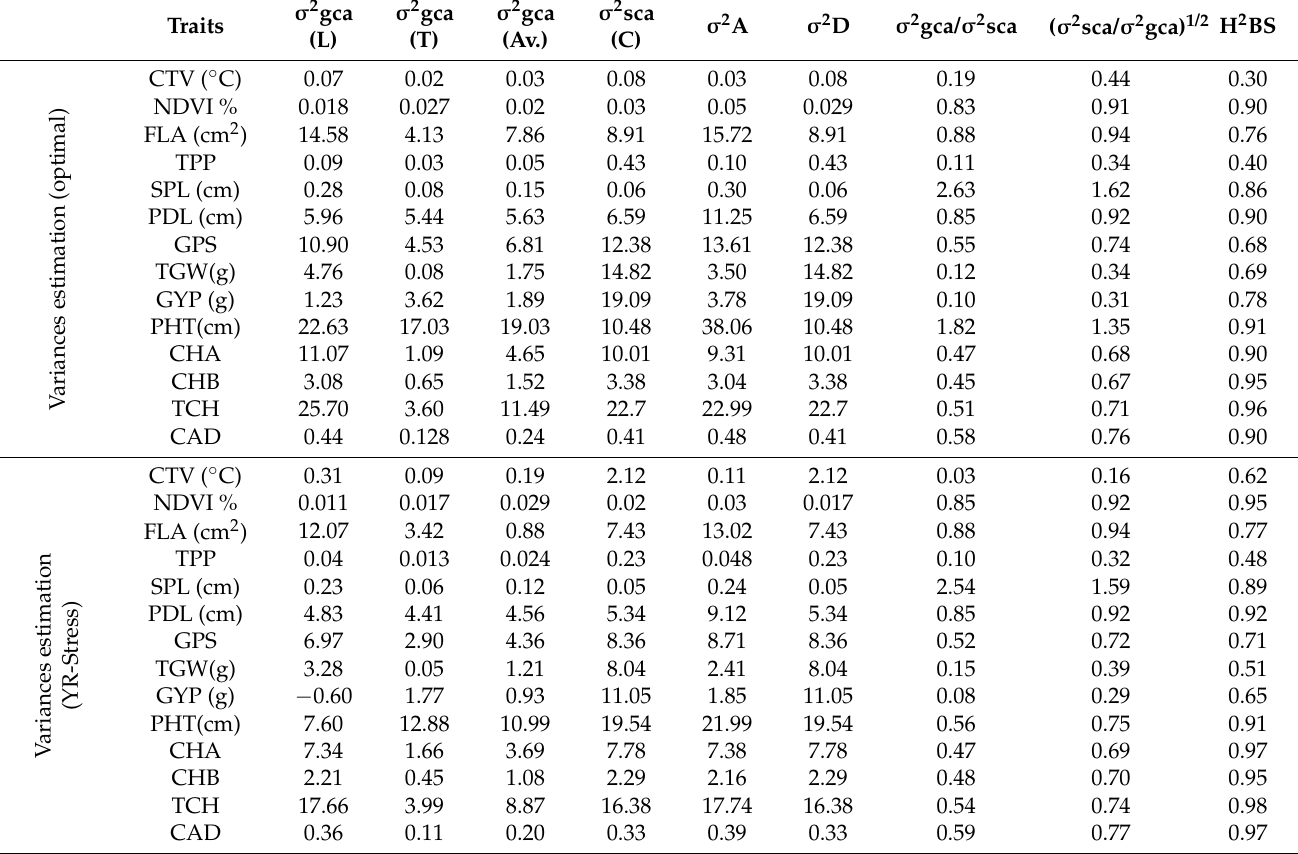
Table 6. Estimation of related variances ( σ 2 ) and heritability for physiological, biochemical, yield and component traits under optimal and YR disease stress